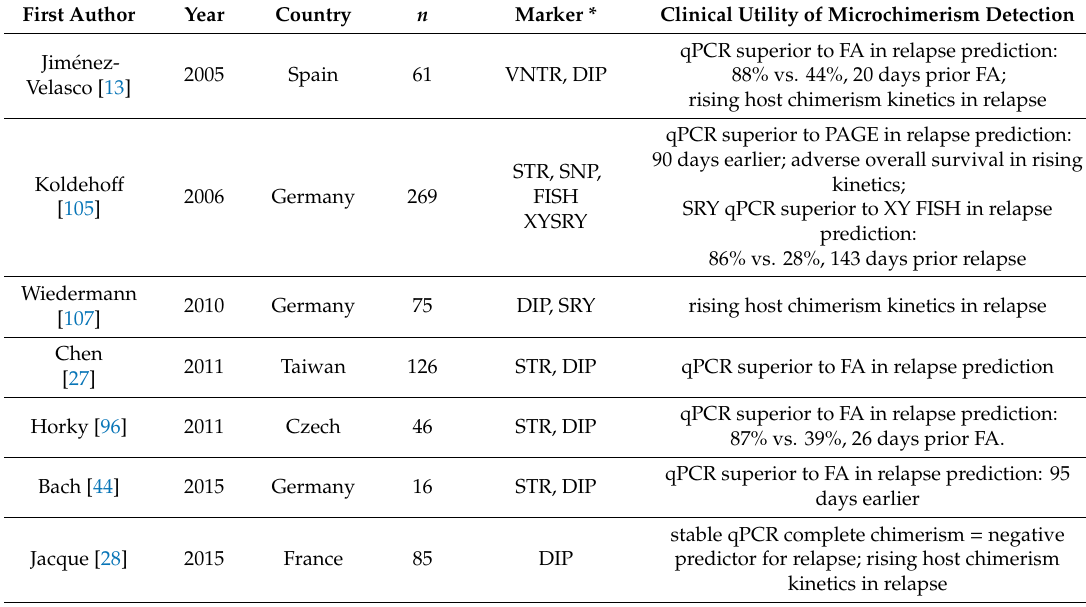
Table 3. Potential advantages and clinical applicability of sensitive microchimerism detection in allo-HSCT based selected